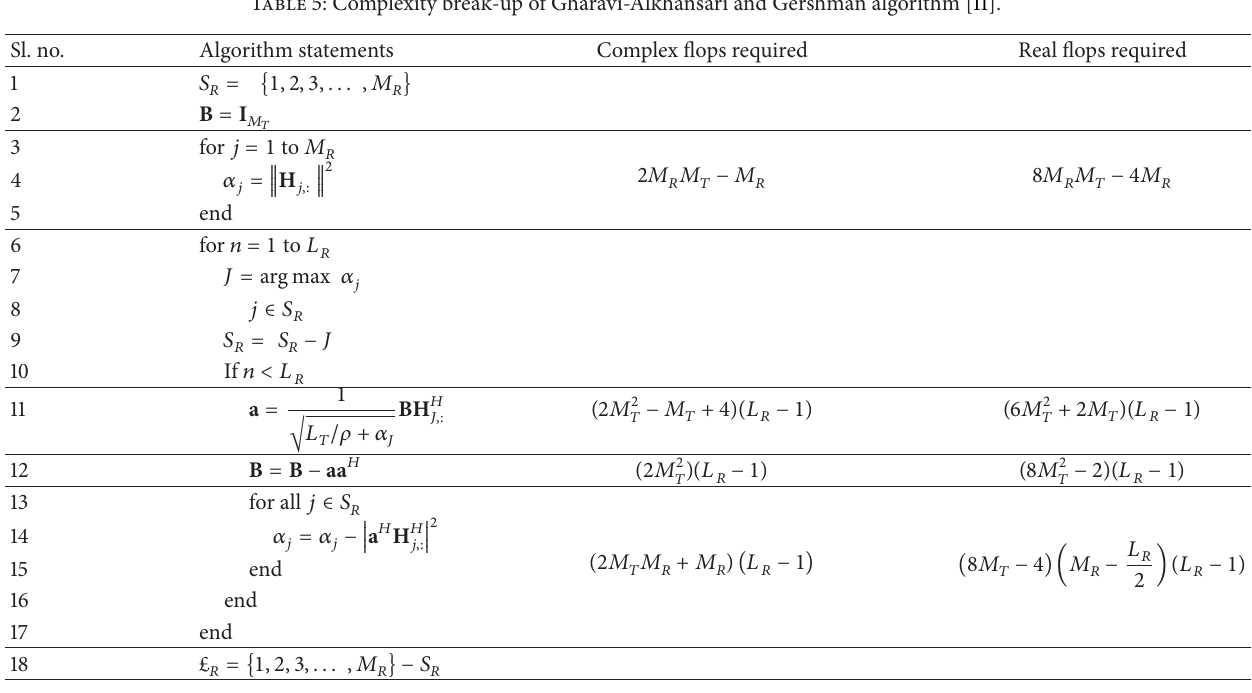
Figure 10 is on the number of real-real flops versus the number of selected antennas. As seen in the figure, the number of flops demanded by the proposed algorithm is only very slightly greater than the Molisch et al.